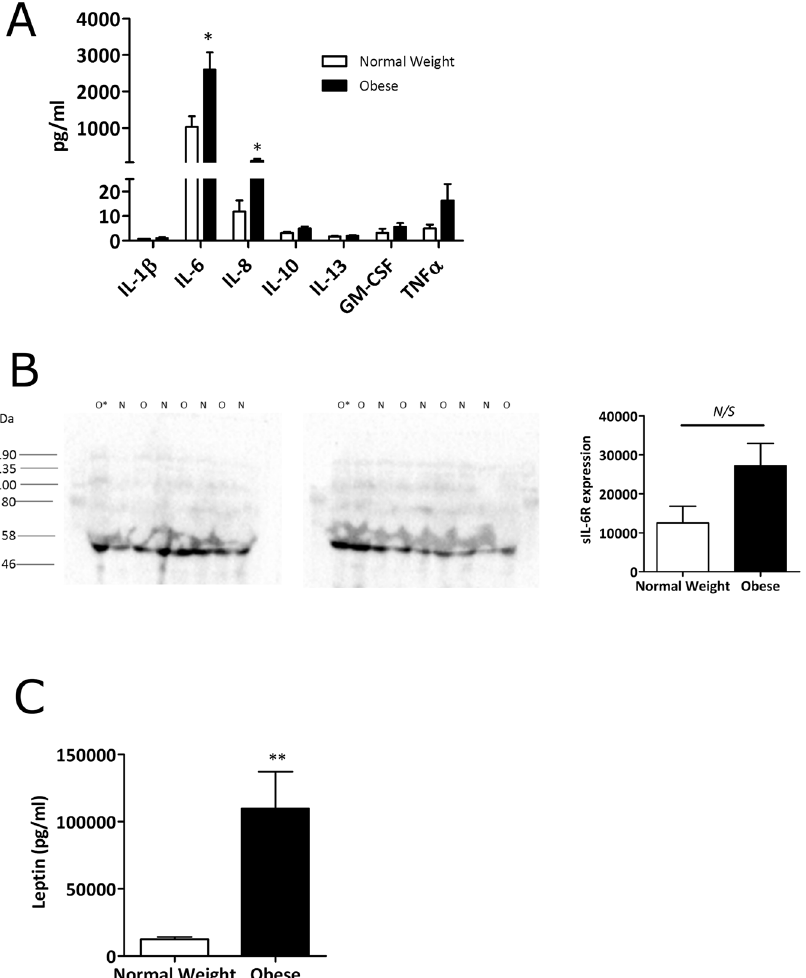
Figure 1. Synovial fluid from obese OA patients contains greater amounts of IL-6 and IL-6R than synovial fluid from normal-weight OA patients. ( A ) Bio-plex assay data showing the profile of inflammatory markers present in the synovial fluid of normal-weight (n = 8) and obese (n = 8) OA patients. ( B ) sIL-6R expression in n = 8 normal-weight (N) and n = 8 obese (O) OA synovial fluid samples was determined by Western blotting and densitometry loaded for equal total protein content (20 µ g). O * represents an obese sample that was loaded onto both blots for standardisation. ( C ) Bio-plex assay data showing leptin concentration in the synovial fluid of normal-weight (n = 19) and obese (n = 27) OA patients. Data are mean ± SEM. Statistical significance was determined by Mann-Whitney U test. * p < 0.05, ** p < 0.01, N/S = not